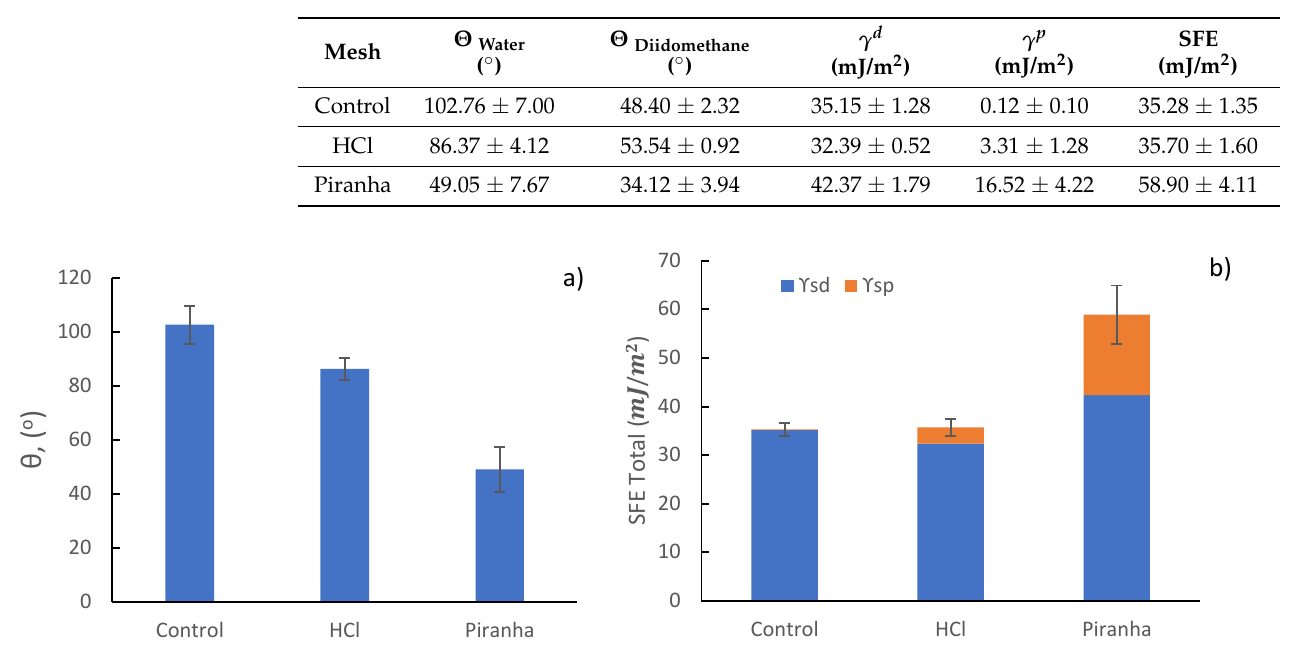
Figure 6. θ values ( a ) and SFE values ( b ) of cpTi treated with different passivation conditions.